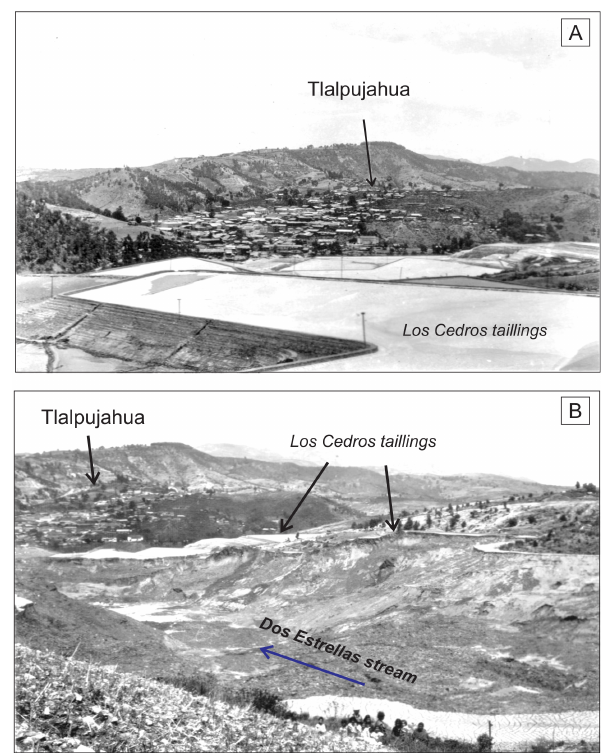
Figure 4. Panoramic views in 1937 from the southeast that show (a) Los Cedros tailings dam with a platform-like form prior to the collapse and (b) The tailings and the Dos Estrellas stream scoured by the flood after the collapse. See people standing on the hill in the